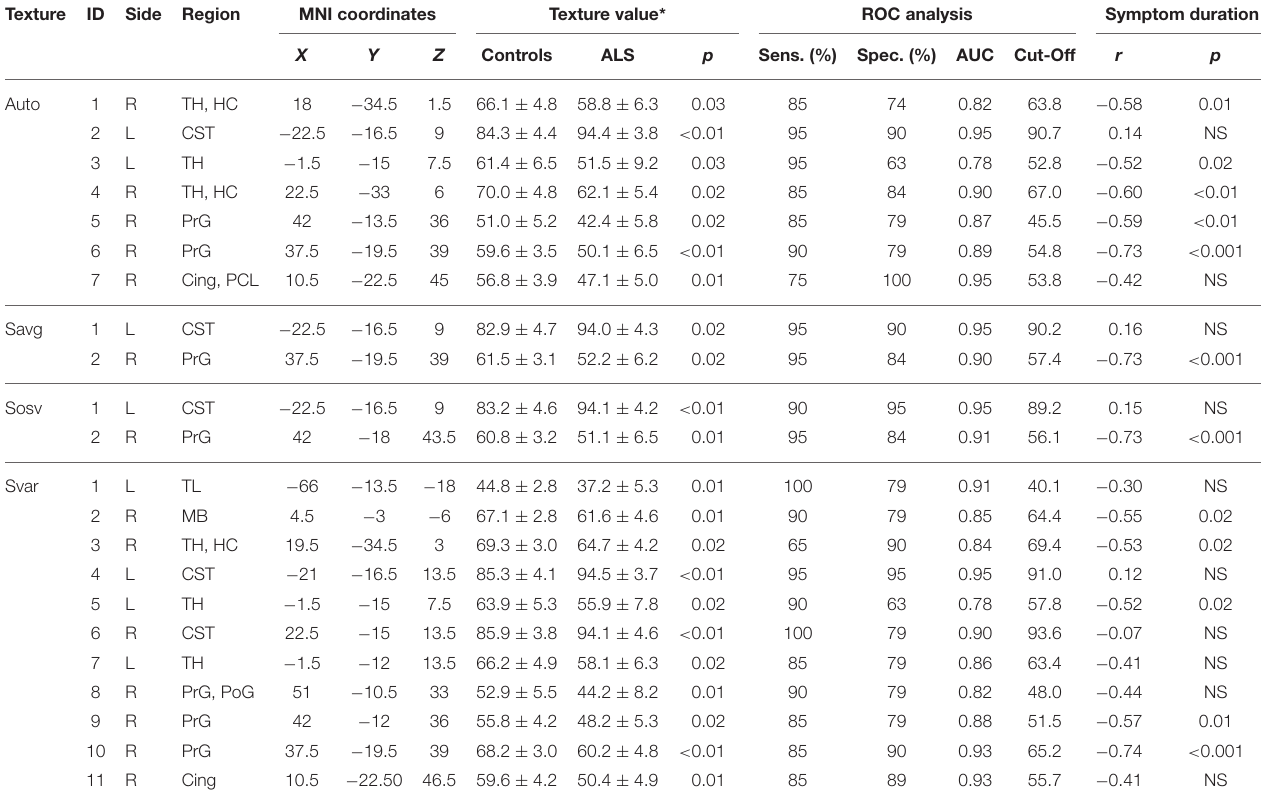
TABLE 1 | Regions showing significant texture feature differences in patients with ALS compared to healthy controls (corrected for multiple comparisons by FDR at p < 0.05) and their correlation with disease duration. Texture ID Side